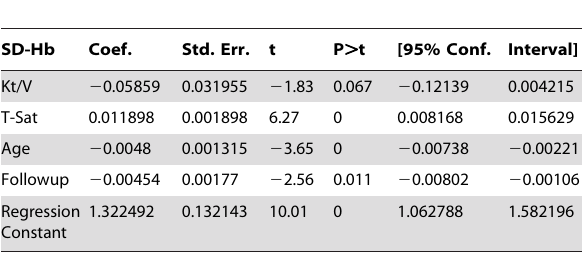
Table 2. Stepwise regression model of